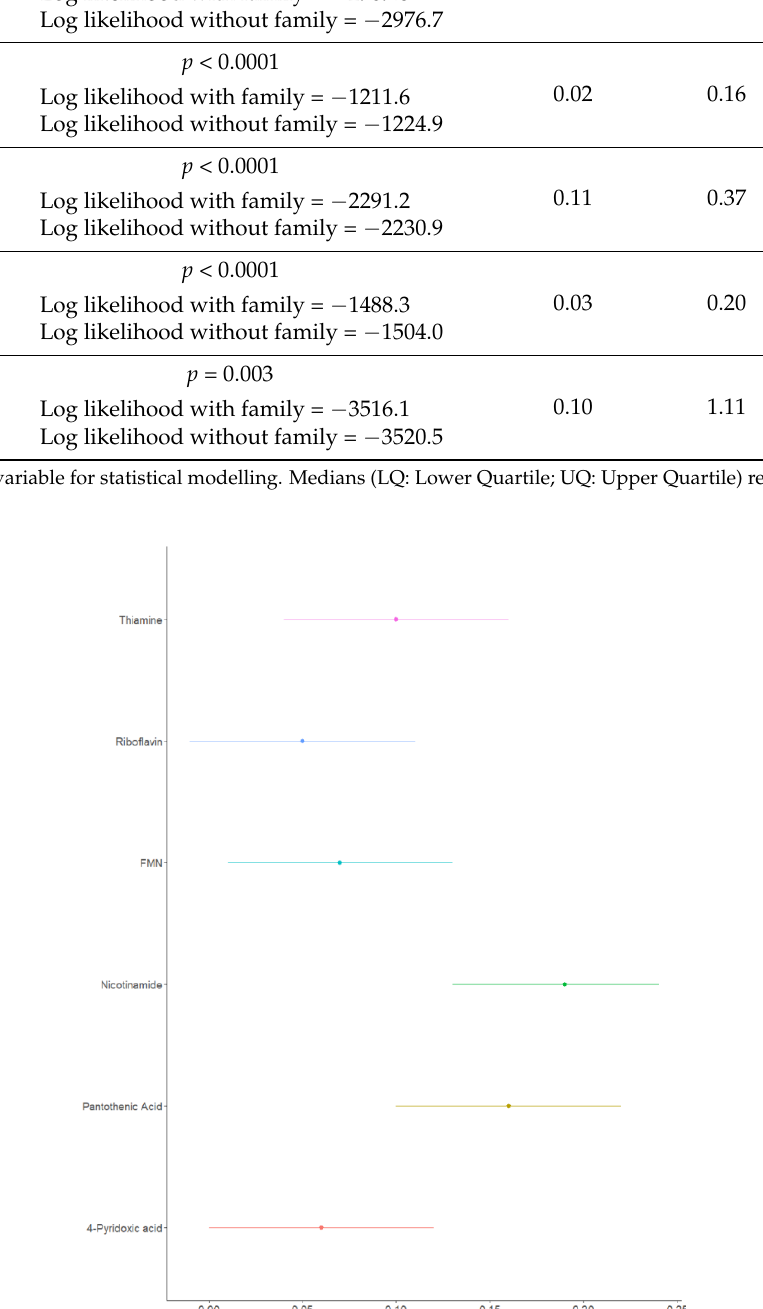
Differences in plasma concentrations were identified between children and adults for all compounds except for flavin mononucleotide (FMN) (Table 3). Thiamine and nicotin- amide had higher concentrations in children (median (lower quartile; upper quartile): 4.14 (2.74; 6.13) nM ; 430.85 (285.61; 730.60) nM respectively) when compared to adults (2.14 (1.05; 4.11) nM; 396.41 (268.50; 640.74) nM respectively; p < 0.0001). By contrast, riboflavin, pantothenic acid, and 4-pyridoxic acid had markedly higher concentrations in adults (14.44 (9.24; 25.03) nM; 179.94 (140.02; 238.19) nM; 15.58 (9.24; 25.59) nM respectively) than children (14.24 (9.85; 21.2) nM; 173.72 (144.76; 206.79) nM; 11.72 (7.75; 17.50) nM respec- tively; p ≤ 0.001) (Table 3). Given the wide age distribution in the parent subgroup (28–71 y), we further investigated whether B vitamer concentrations differed with adult age. Ri- boflavin, pantothenic acid, and 4-pyridoxic acid ( p ≤ 0.01 for all) exhibited positive associ- ations with age in the adult subgroup (Figure 3 and Supplementary Table S4).